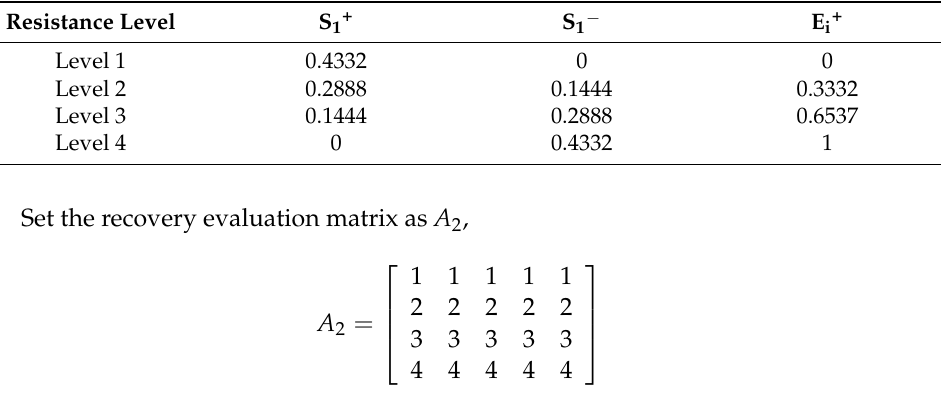
Table 11. Resistance grade